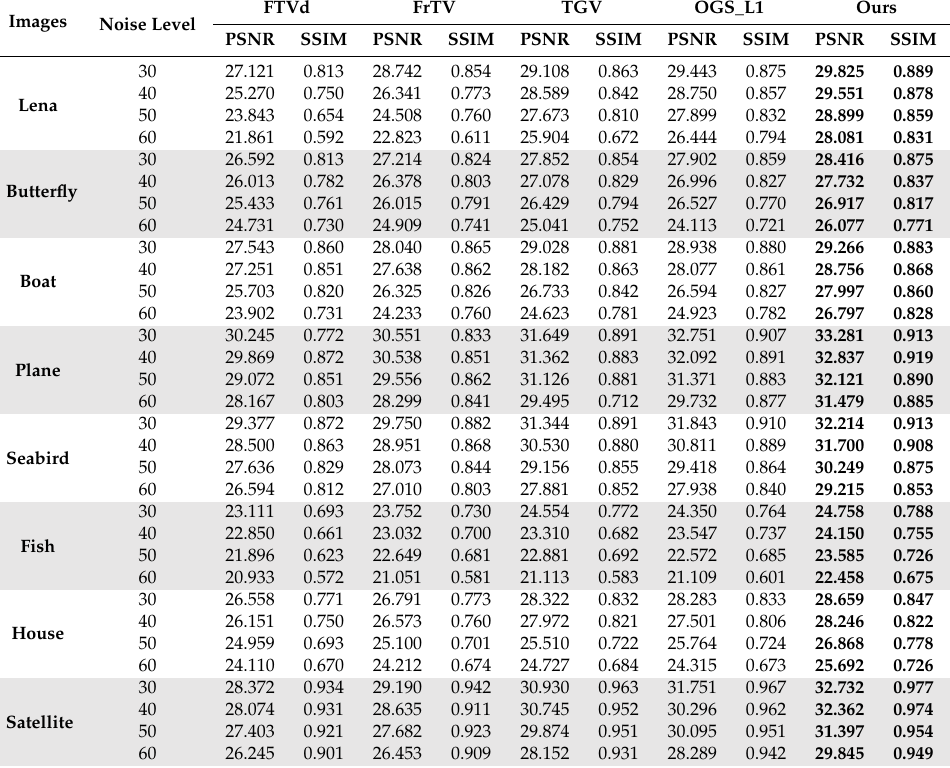
Table 2. PSNR (dB) and SSIM values generated by various algorithms in deblurring and denoising different